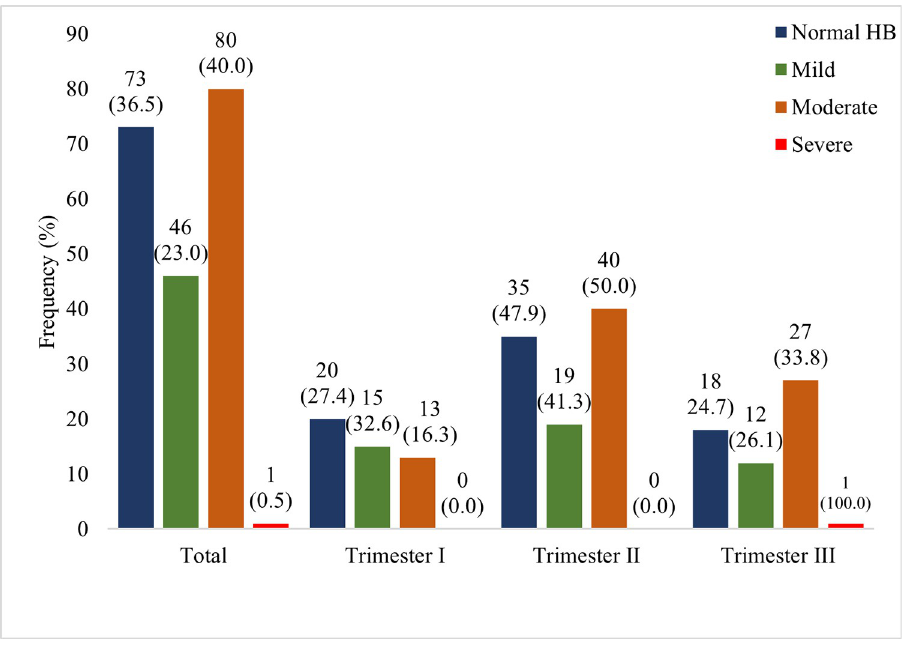
Fig 3. Anaemia classification stratified by gestational period. HB-Hemoglobin.